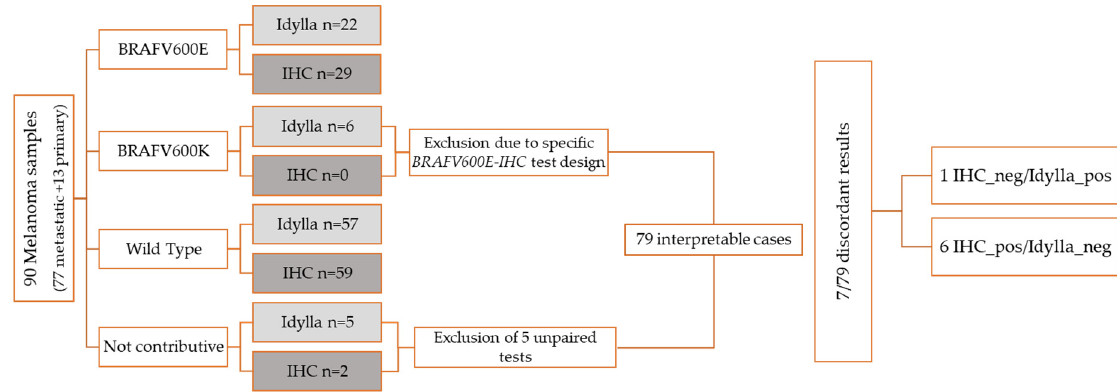
Figure 1. Flowcharts of the results of testing for BRAF with IHC and molecular method.